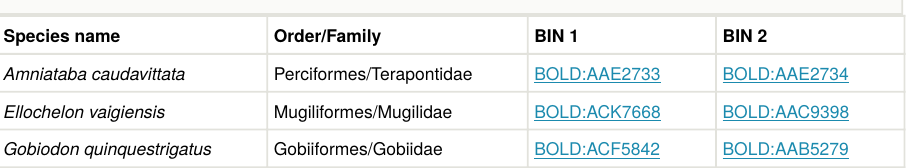
Discordances between BIN and species assignments (Species assigned to two